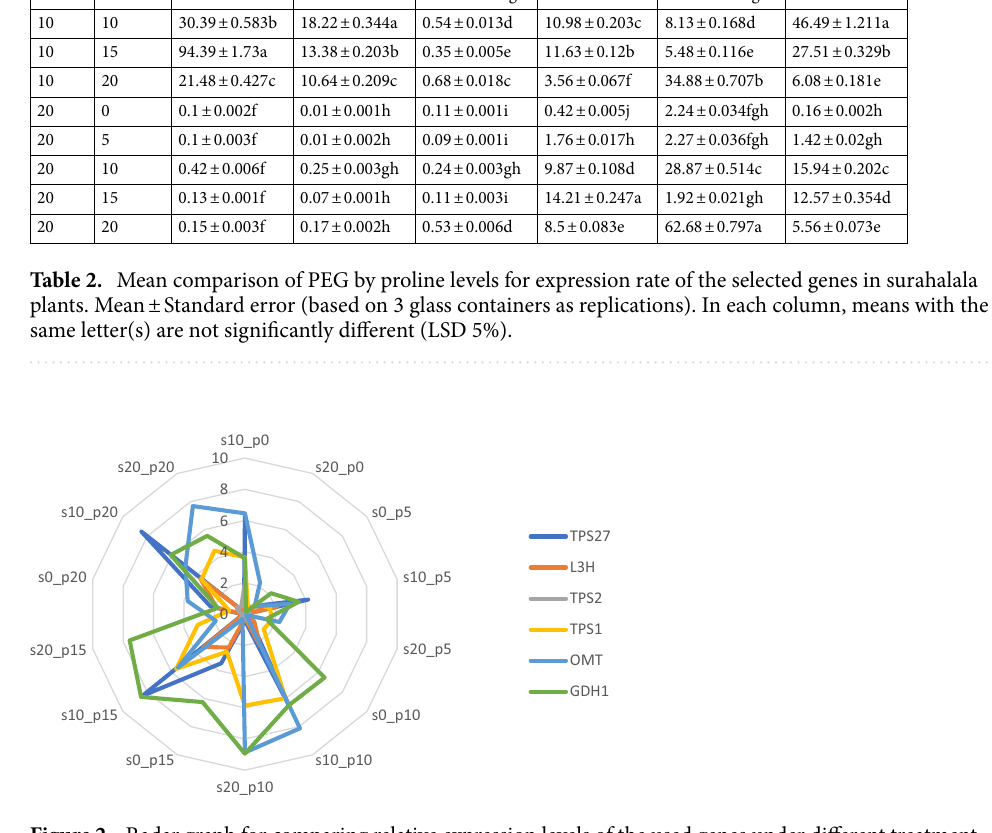
Figure 2. Radar graph for comparing relative expression levels of the used genes under different treatment levels of PEG and proline in surahalala plants. The analyses have been conducted on the average of the 8 replications in the experiment. S0_p0: 0% PEG and 0 µm proline; s0_p5: 0% PEG and µm proline; s0_p10: 0% PEG and 10 µm proline; s0_p15: 0% PEG and 15 µm proline; s0_p20: 0% PEG and 20 µm proline; s10_p0: 10% PEG and 0 µm proline; s10_p5: 10% PEG and 5 µm proline; s10_p10: 10% PEG and 10 µm proline; s10_p15: 10% PEG and 15 µm proline; s10_p20: 10% PEG and 20 µm proline; s20_p0: 20% PEG and 0 µm proline; s20_ p10: 20% PEG and 10 µm proline; s20_p15: 20% PEG and 15 µm proline; s20_p20: 20% PEG and 20 µm